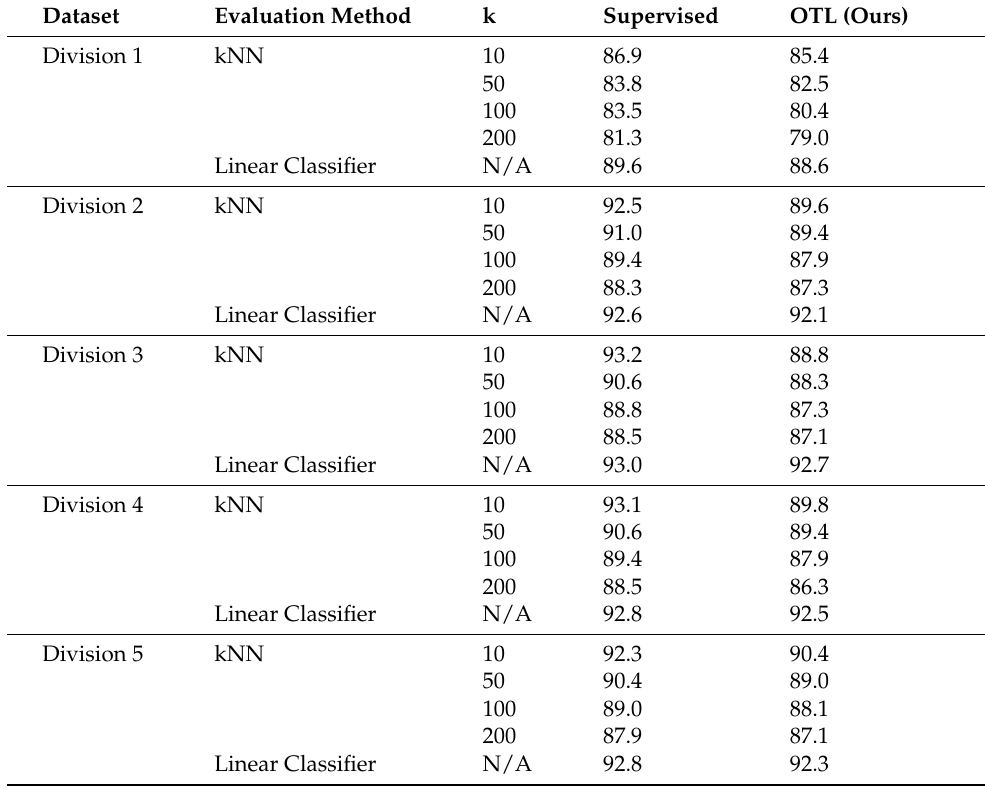
Table 13. Five different ways to divide the dataset SIRI WHU google.